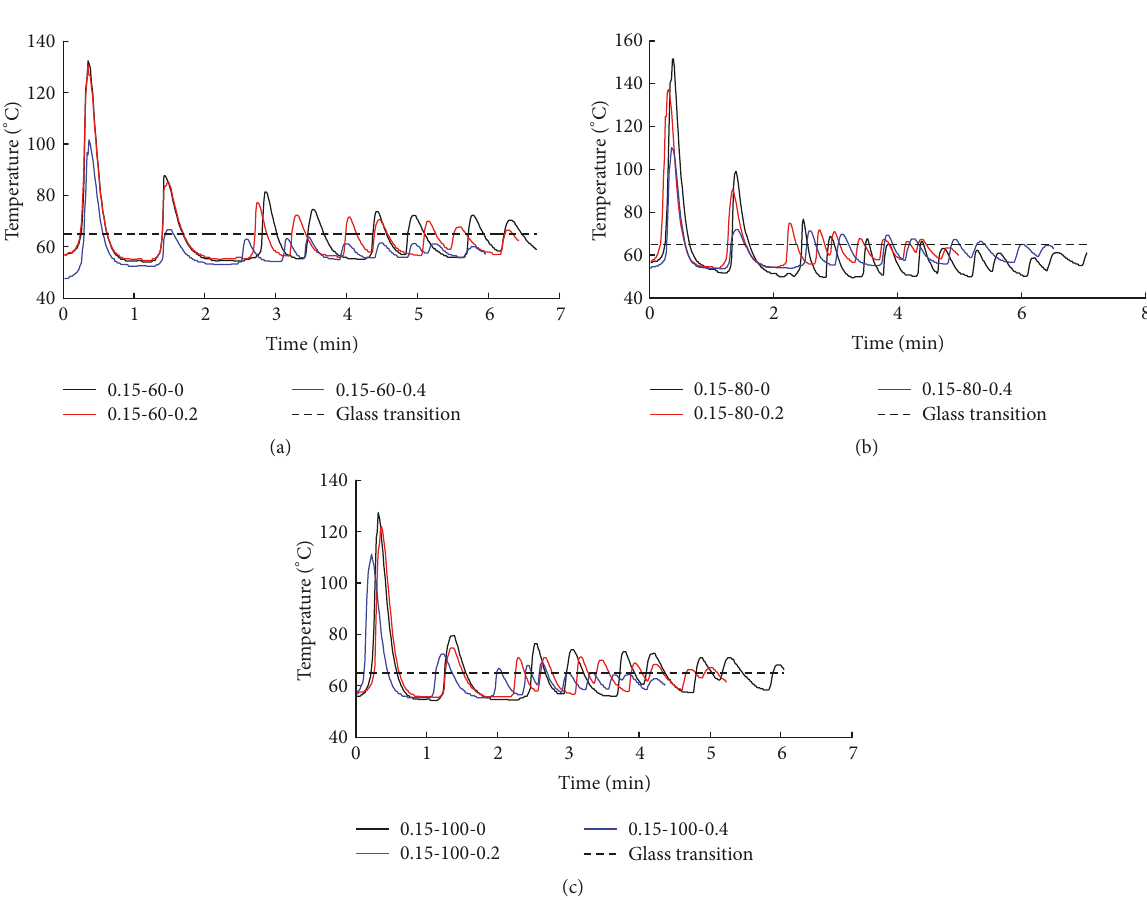
Figure 14: The temperature files under different levels of deposition velocity and air